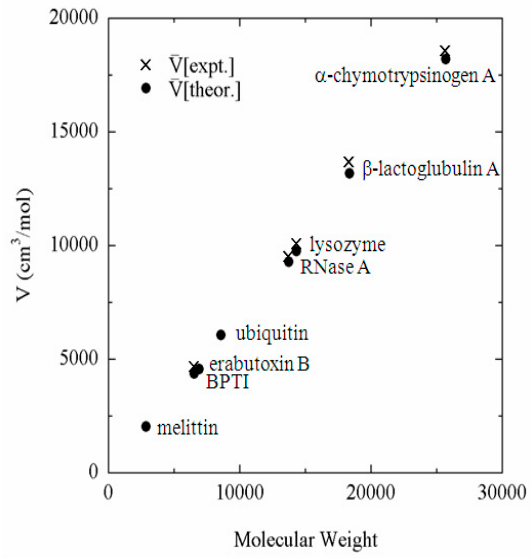
Figure 1. Partial molar volume of proteins in water plotted against molecular weight. (The figure was reprinted from Ref. [40]. Copyright (2005) American Chemical Society.).